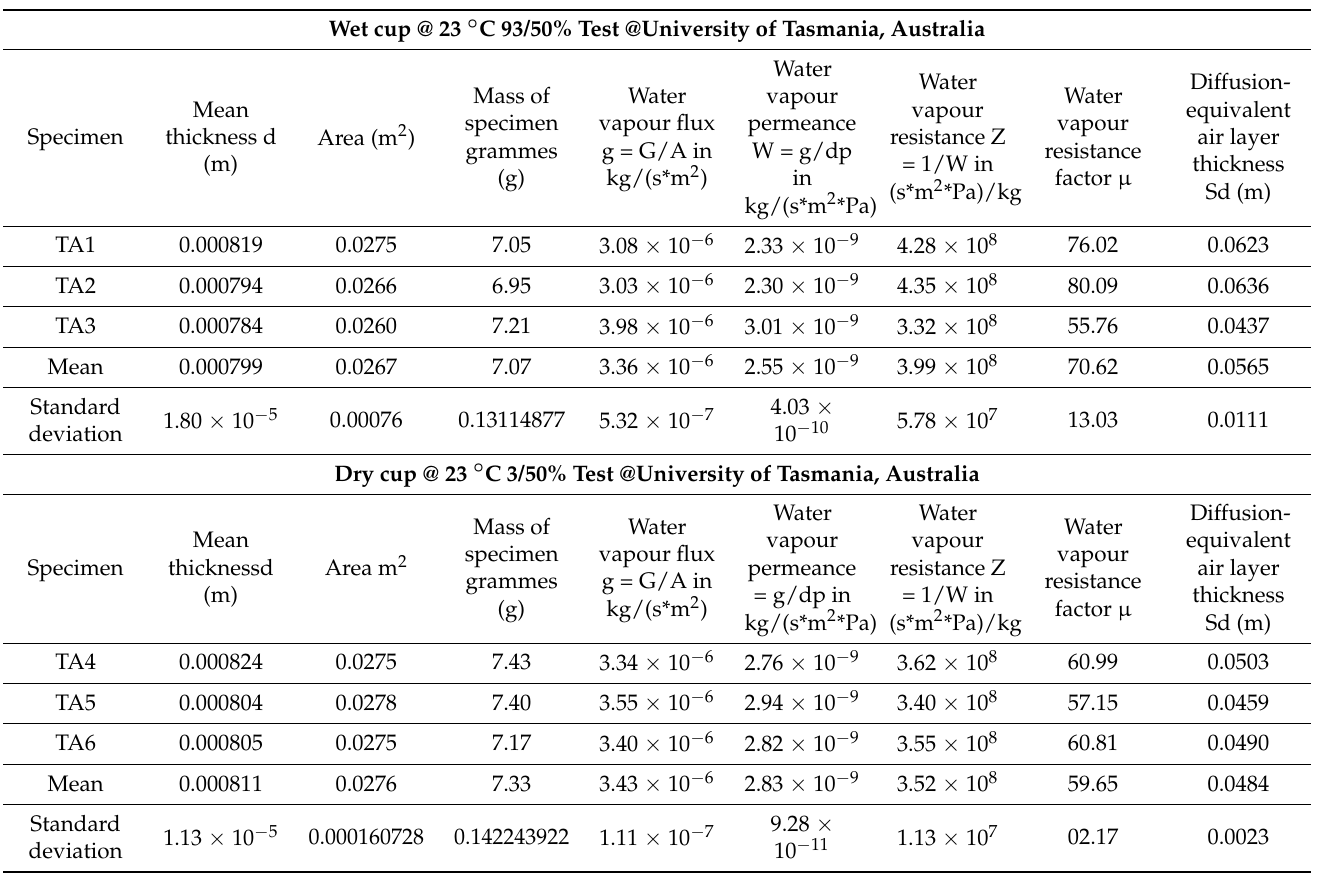
Table 4. Water vapor diffusion properties measured at